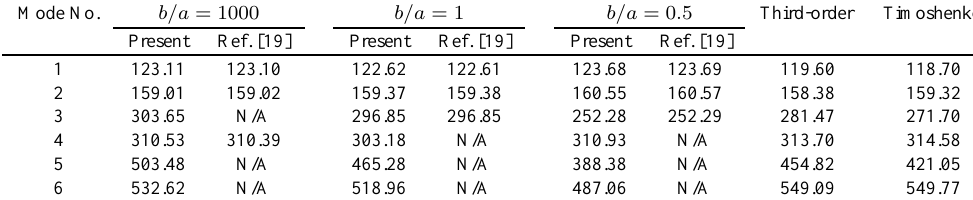
Table 1 Comparison of natural frequencies (in Hz) of Simply-Supported rectangular section beam